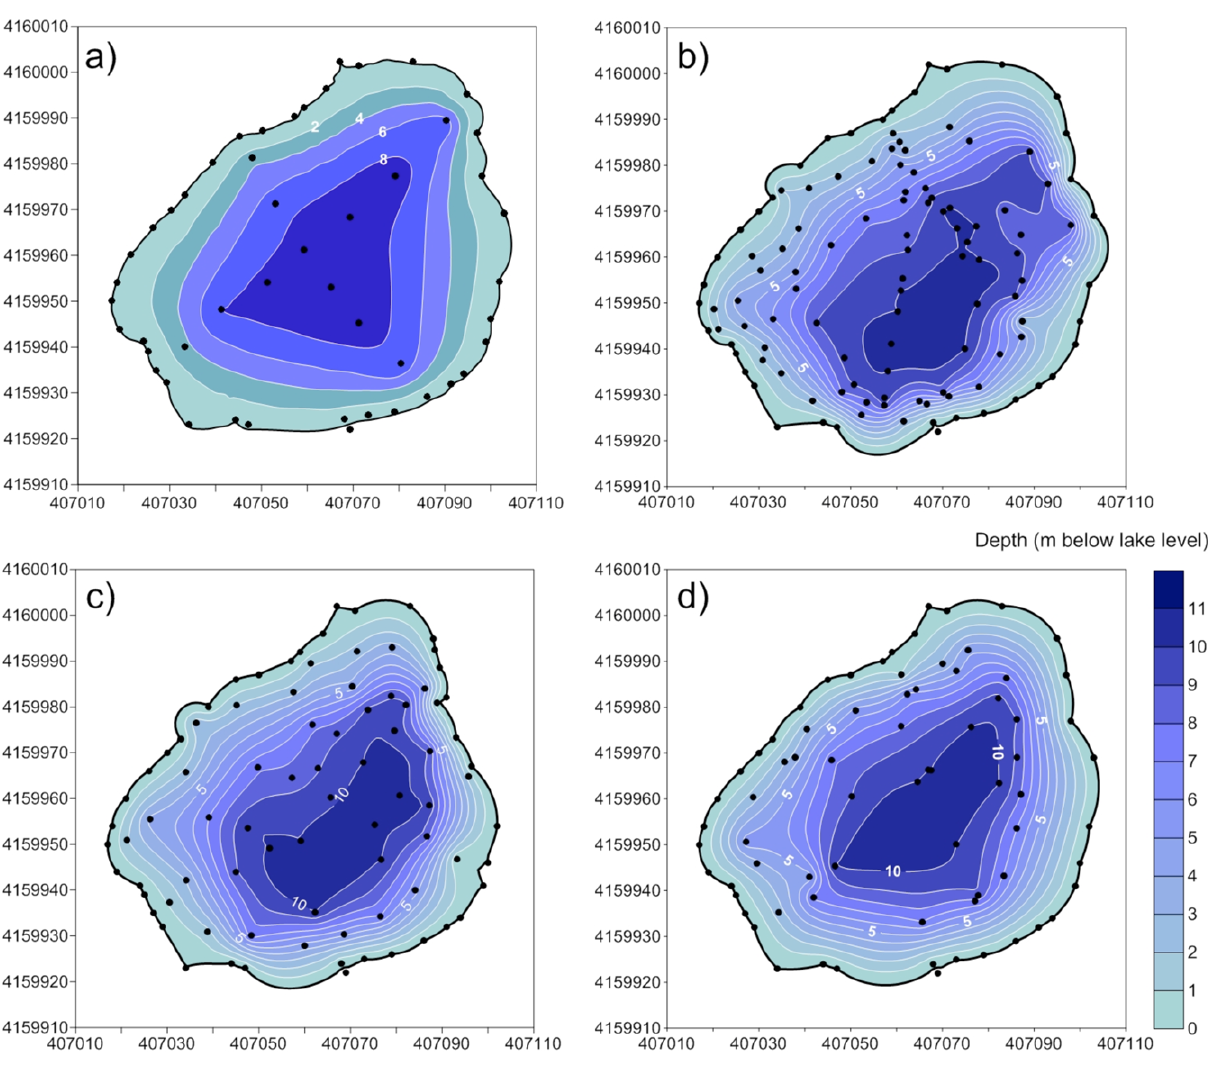
Figure 8. Morphobathymetric maps of Lake Sfondato: a) 2003 survey; b) 2006 survey; c) 2008 survey; d) 2009 survey. Coordinates expressed in UTM- WGS1984 system and referred to 33S Zone. Dark circles are the measurement